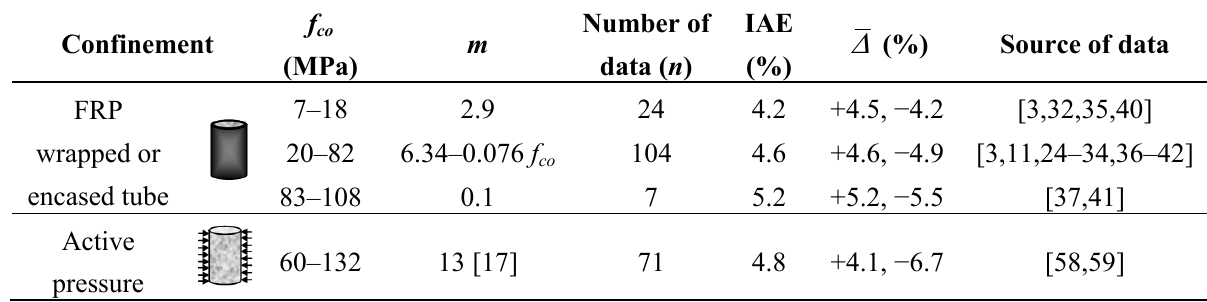
Table 1. The variation of predicted m constant through two confining techniques.